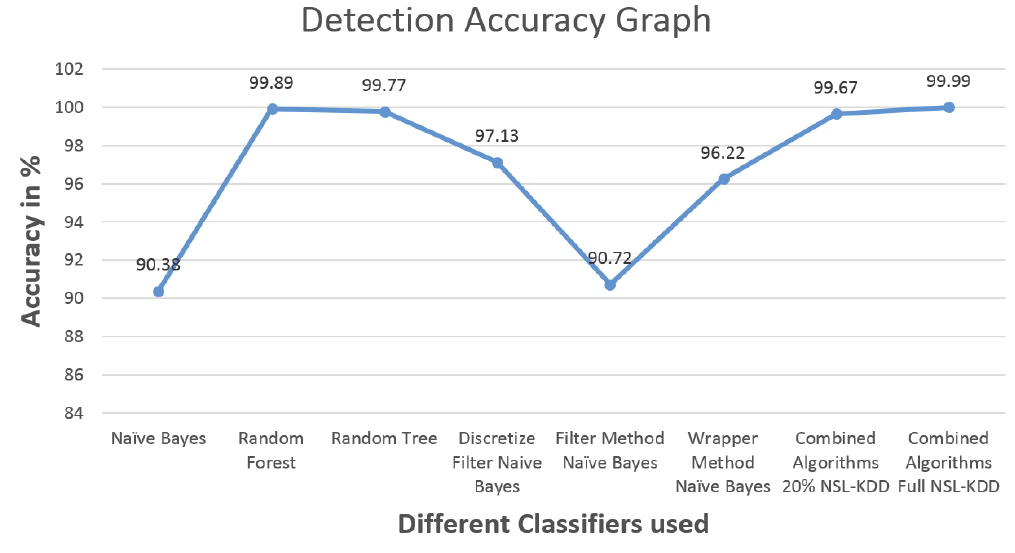
Fig. 7. Detection accuracy comparison